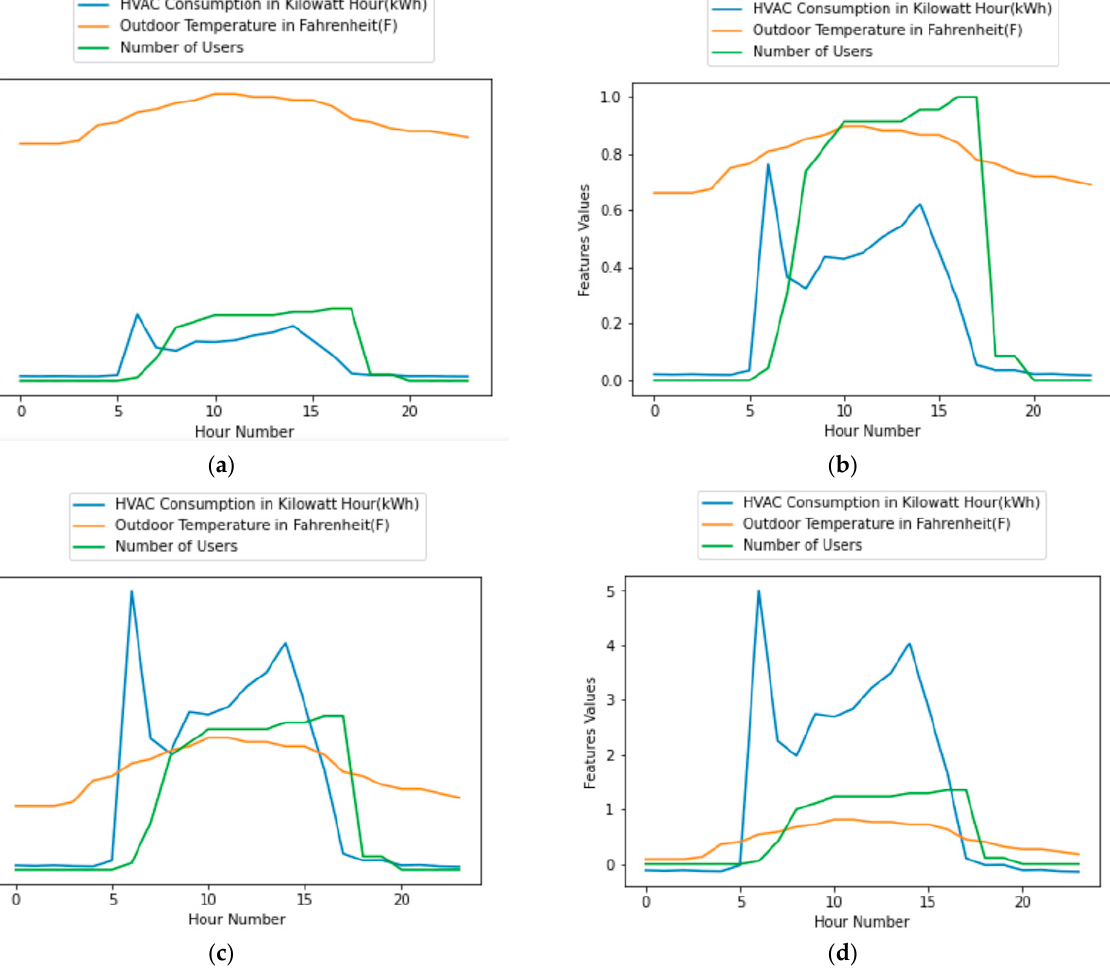
Figure 11 . Effect of data scaling: ( a ) original data, ( b ) min-max scaler, ( c ) standard scaler, ( d ) robust scaler .